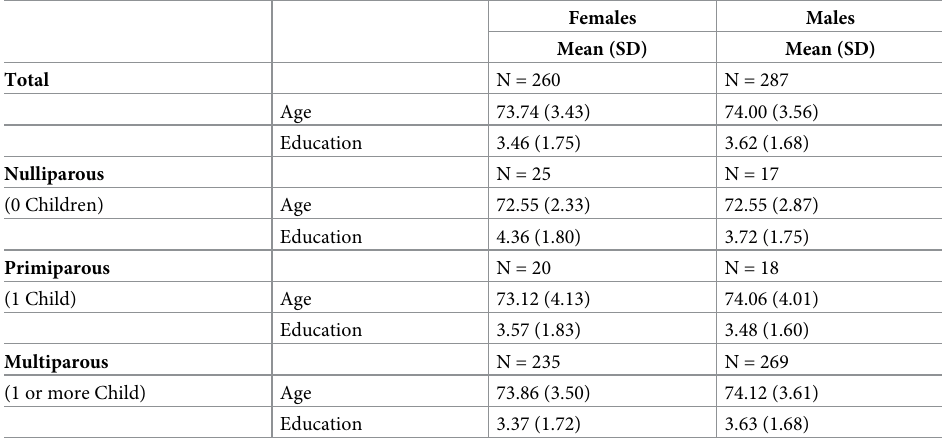
Table 1. Demographic statistics and sample sizes for females and males for each analysis.